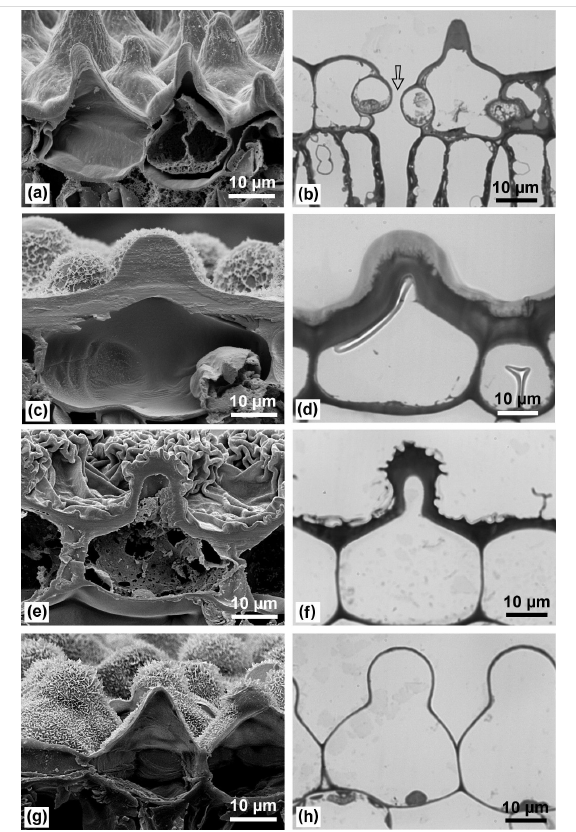
Figure 9: SEM and LM images of cross sections through the papillae. Lotus (a,b) and Euphorbia myrsinites (c,d) have almost massive papillae, those of Alocasia macrorrhiza (e,f) have a relatively thick outer wall; the epidermal cells of Colocasia esculenta have thin walls (g,h). The arrow in (b) marks a